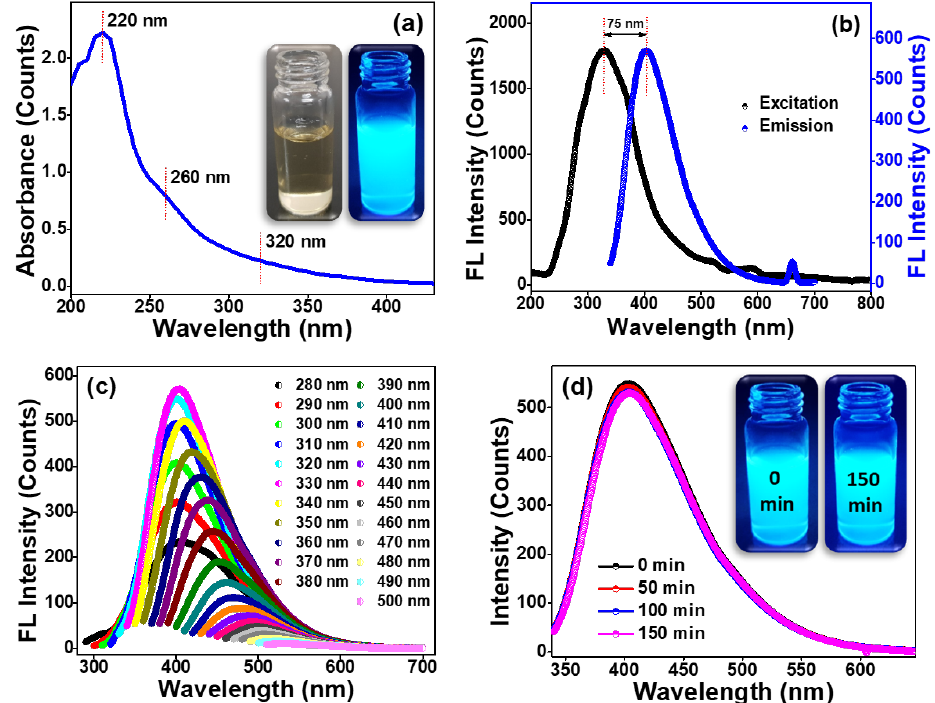
Figure 5. ( a ) UV – Vis absorption spectrum of the synthesized P-CDs. Inset ( a ): Digital photographic image of the P-CDs aqueous dispersion under visible light (left) and UV light (right). ( b ) Fluorescence excitation and emission spectra of synthesized P-CDs. ( c ) Fluorescence emission spectra of synthesized P-CDs at excitation wavelength from 280 to 500 nm in 10 nm increments. ( d ) Fluorescence emission spectra of synthesized P-CDs at UV irradiation time from 0 to 150 min in 50 min intervals. Inset ( d ): Digital photographic image of the P-CDs aqueous dispersion under UV light (365 nm) at UV irradiation time 0 min (left) and 150 min (right).